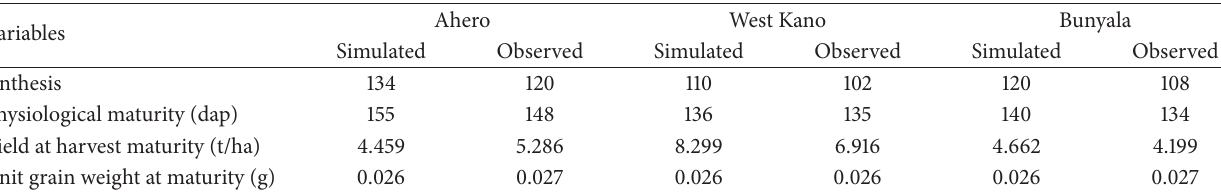
Table 4: Main growth and development variables for IR 2793-80-1 under system of rice intensification in Ahero, West Kano, and Bunyala irrigation schemes, Kenya.